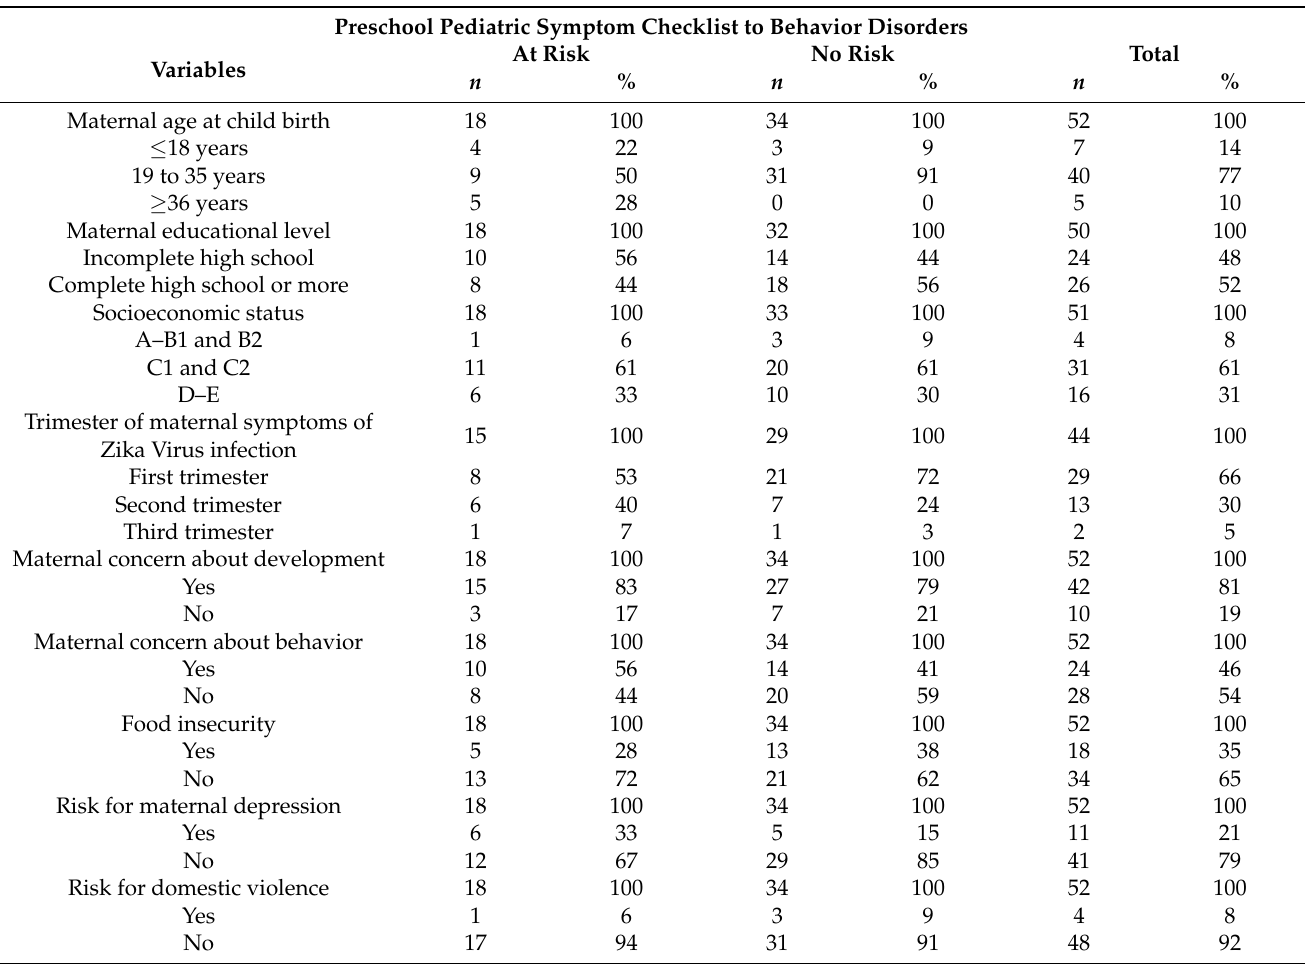
Table 1. Maternal data distribution of children ( n = 52) according to risk of behavioral alteration assessed with the Preschool Pediatric Symptom Checklist of the SWYC questionnaire.